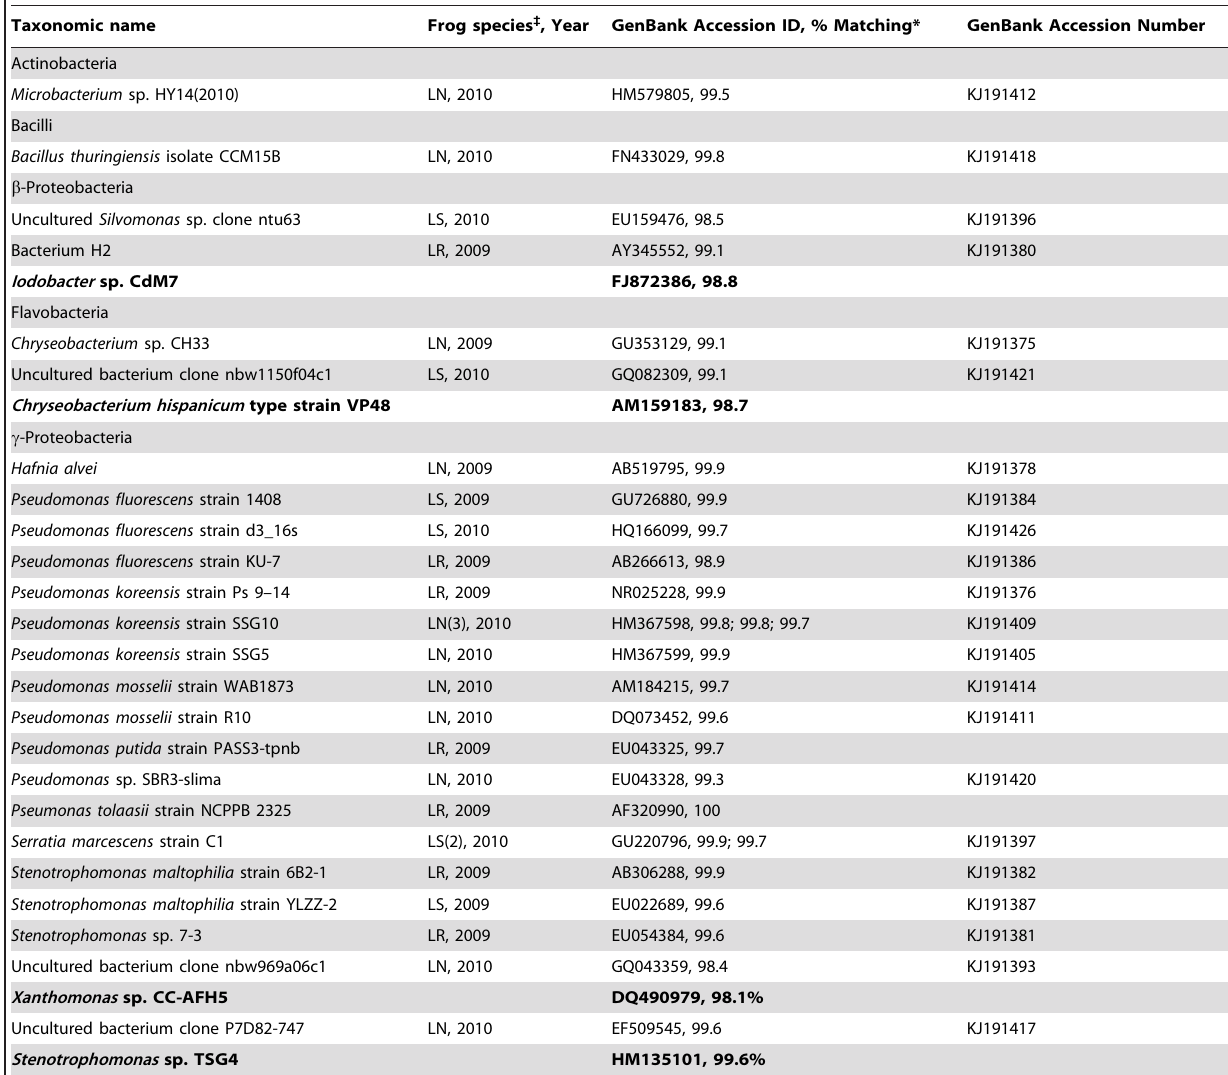
Table 1. Bacteria identified as strongly inhibitory of Batrachochytrium dendrobatidis and used in the experimental challenge